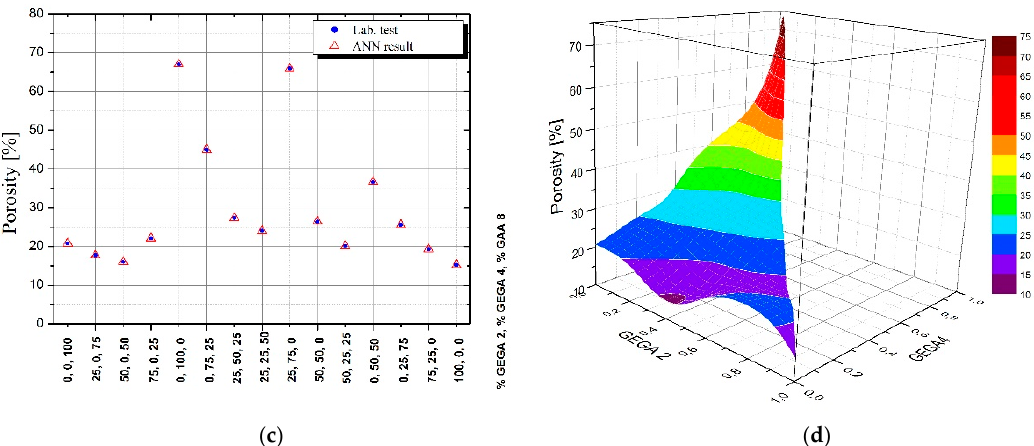
Figure 3. Illustration of the results, obtained by means of using ANN for porosity of LWC as a function of GEGA 2 mm and GEGA 4 mm shares in the specimen, ( a ) results generated by ANN for individual testing datasets ( b ) relative error of ANN for individual testing datasets ( c ) comparison of measurement results with values obtained by ANN for training database, ( d ) values of porosity of LWC predicted by ANN for intermediate points between measurement data from the training dataset.